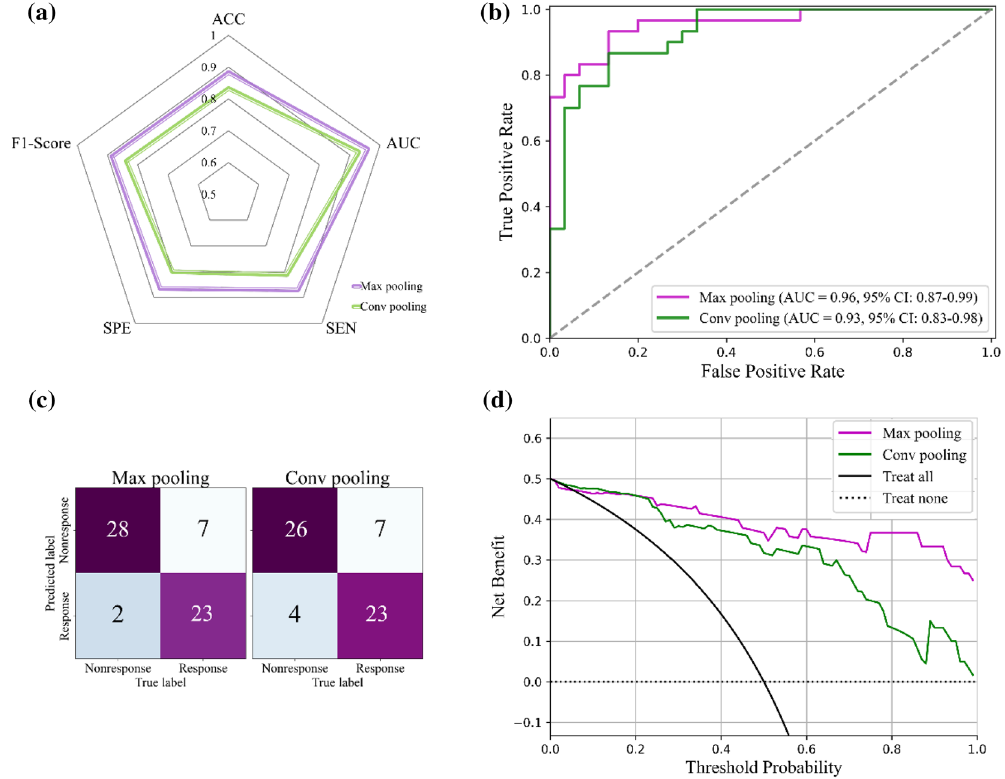
Figure 6. Performance of the two counterparts with different representation modules. ( a ) Statistical results; ( b ) The ROC curve; ( c ) The confusion matrix; ( d ) The DCA